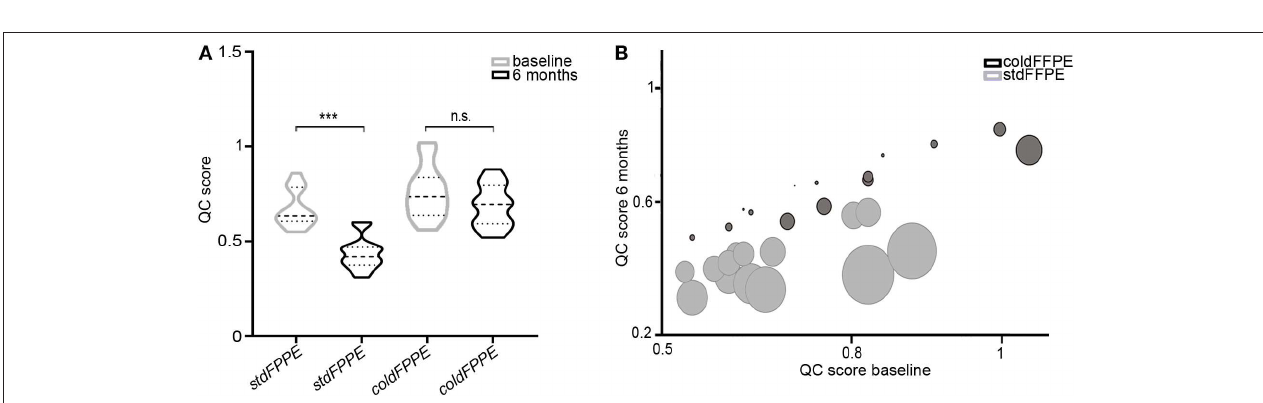
FIGURE 4 | QC score distribution in the subgroup analysis of the 14 tissue pairs with a second DNA extraction after 6 months from collection/fixation. (A) Violin plots representing the QC scores in a head to head comparison between DNA extraction at baseline and after 6 months, subdivided by standard fixation ( stdFFPE ) and cold fixation ( coldFFPE ). Significantly lower QC scores are observed after 6 months in stdFFPE samples, whereas comparable QC scores are displayed for coldFFPE samples. (B) Bubble plot of the QC score for each patient. The plot showed the basal QC score on the Y axes and the 6-month QC score on the X axes, paired for each sample. The bubble size illustrates the drop in terms of QC score for each couple of DNA samples purified after 6 months of archival. n.s. not significant, *** p <